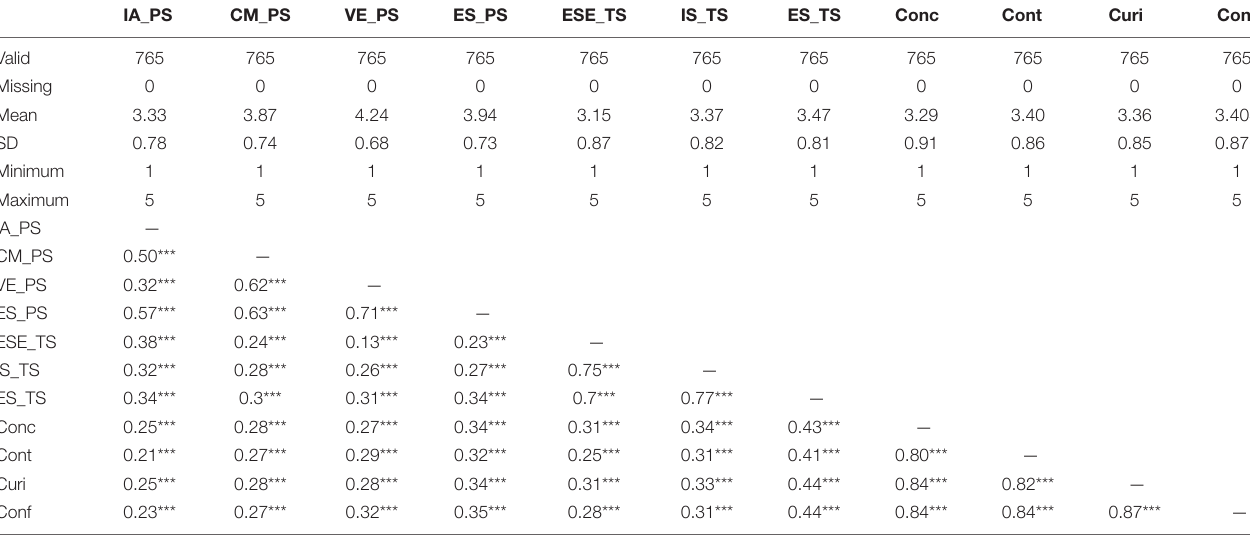
TABLE 2 | Correlations among key variables ( n =